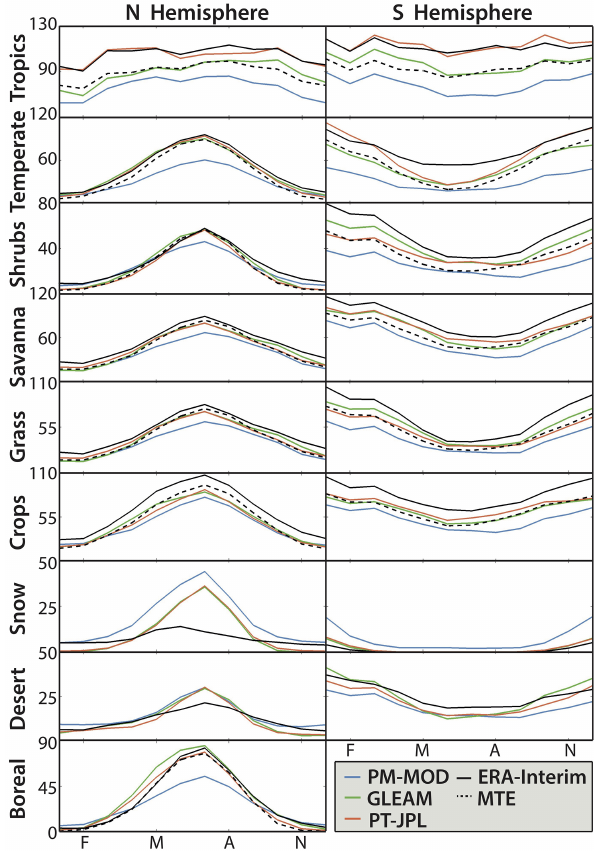
Figure 8. Average seasonal cycle. Monthly climatology of evapo- ration for each IGBP biome (see Fig. 1 for the global distribution of biomes) based on the 2005–2007 period. Northern Hemisphere (left panels) and Southern Hemisphere (right panels) are presented separately. In addition to the PM-MOD, GLEAM, and PT-JPL re- sults, the evaporation from ERA-Interim and MTE is also shown for completeness. Fluxes are displayed in millimetres per month.